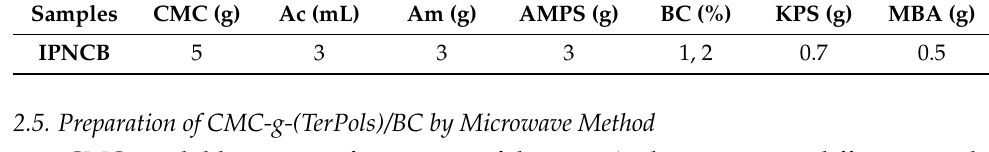
Table 3. Optimized chemical composition of CMC-g-(TerPolys)/BC superabsorbent composite.